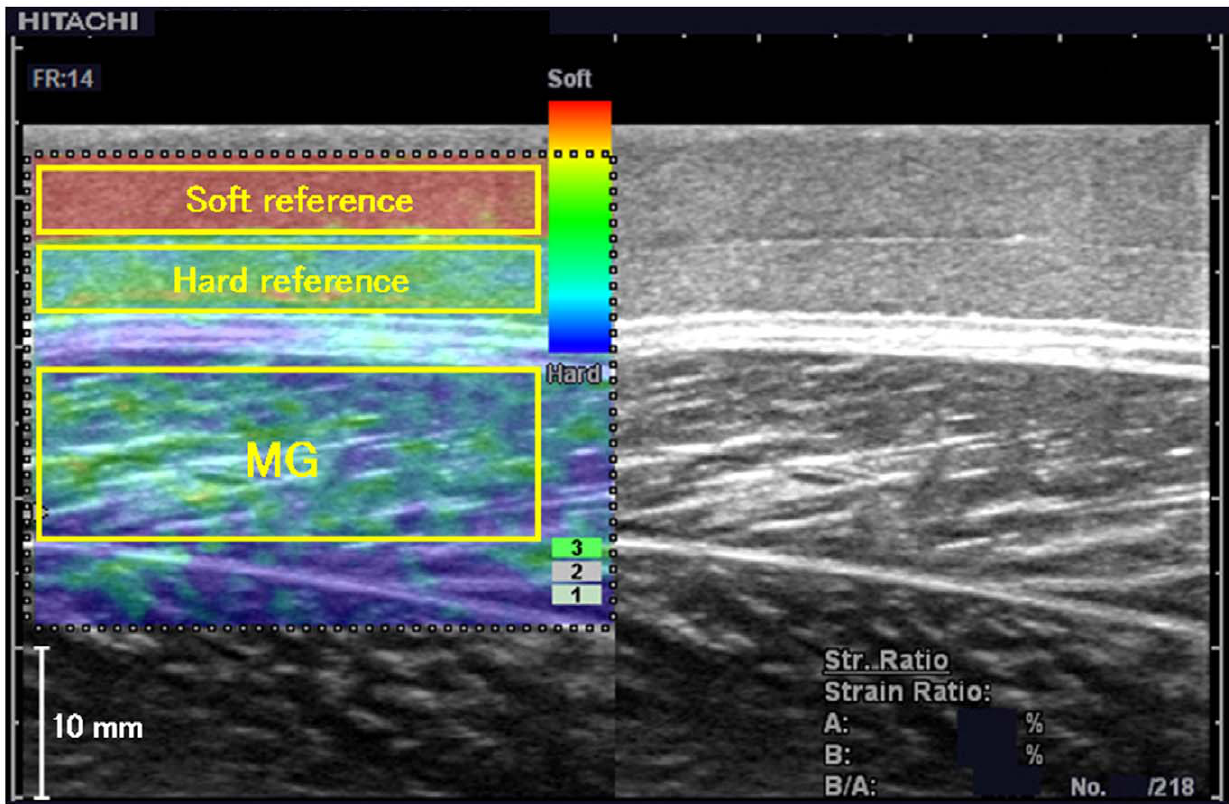
Figure 2. Typical ultrasound elastogram of the invivo human medial gastrocnemius muscle (MG). The yellow rectangles are the regions of interest for the soft reference (7 kPa), hard reference (30 kPa), and